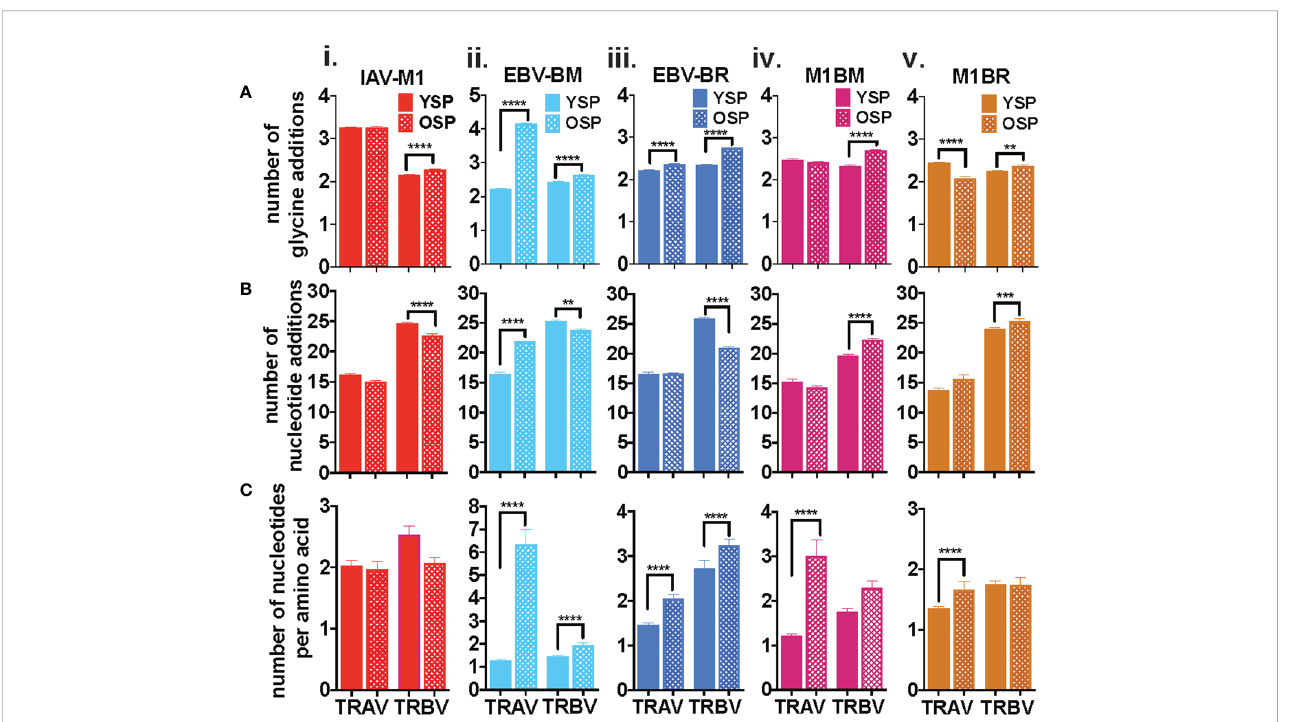
FIGURE 2 Speci fi c features of the CDR3 dominate in IAV-M1 and EBV-cognate and cross-reactive TCR repertoires with increasing age. IAV-M1- and EBV-BM and EBV-BR- speci fi c (cognate) and cross-reactive short-term cultured cells from younger and older donors were tetramer-sorted for high throughput sequencing (Y n=4, O n=4-5). M1BM or M1BR are cross-reactive EBV-BM or EBV-BR single tetramer+ cells sorted from IAV-M1 stimulated short term cultures. Signi fi cant differences were found in the number of glycines ( A i-v, number of nucleotide additions ( B i-v), and number of nucleotides per amino acids ( C i-v) between Y and O and between the epitope speci fi c and cross-reactive responses (Figure S1) for TRAV and TRBV. Multi-variant 2-way ANOVA with adjusted p-value, **p < 0.01, ***p < 0.001, ****p <